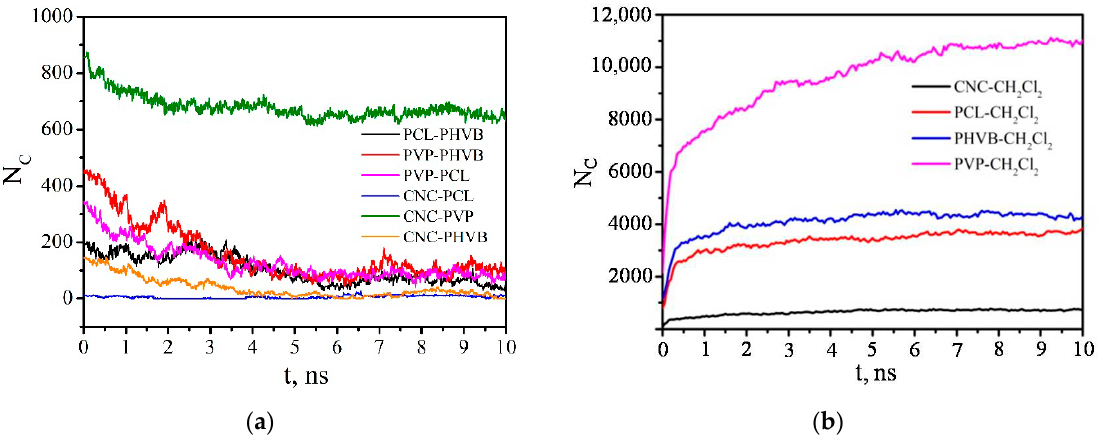
Figure 27. The time dependence of the number of close contacts between any pair of atoms of CNC–polymer, polymer–polymer ( a ), and CNC-DCM, polymer–DCM ( b ).